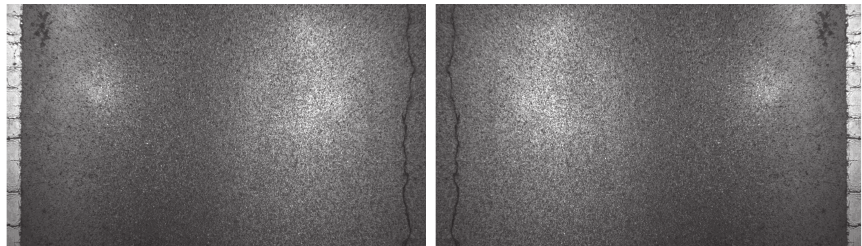
Figure 5: Images of longitudinal crack using flip. (a) Original image. (b) Flipped image. Table 4: PA values of different models using images of different sizes.